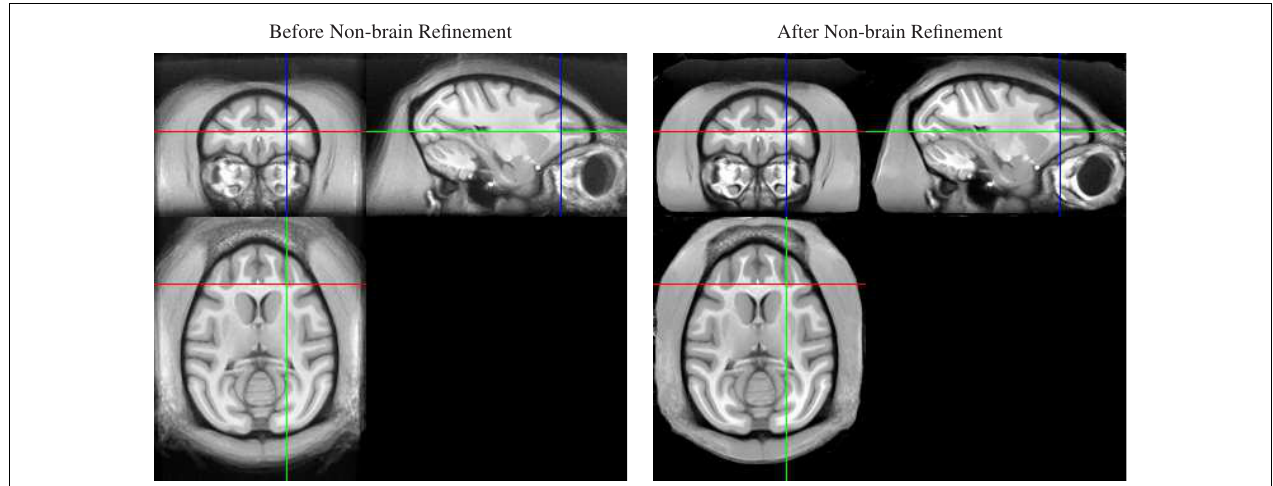
is a whole-head template image that maintains quality of the brain regions achieved by alignment of skull-stripped images, but also provides a consistent embedding of that brain template image into the whole-head